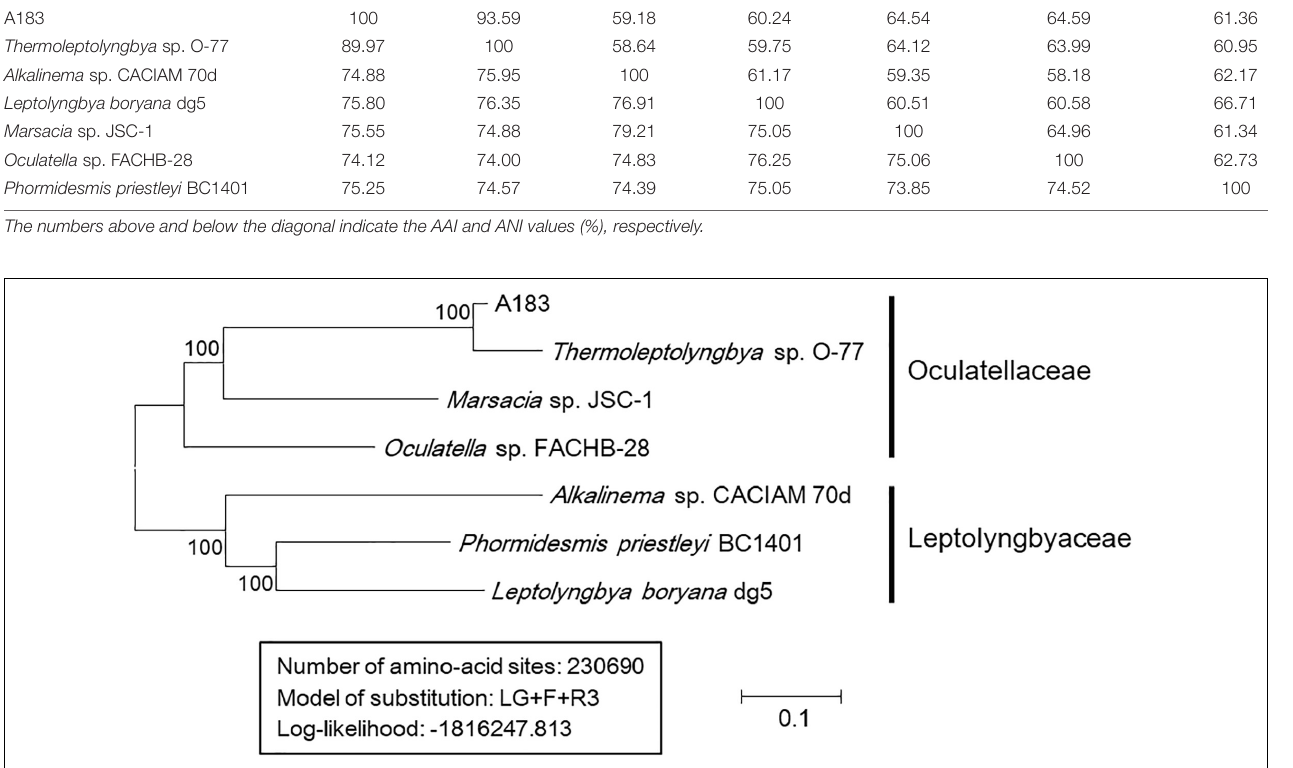
and was not assigned to a specific CRISPR-Cas system. The